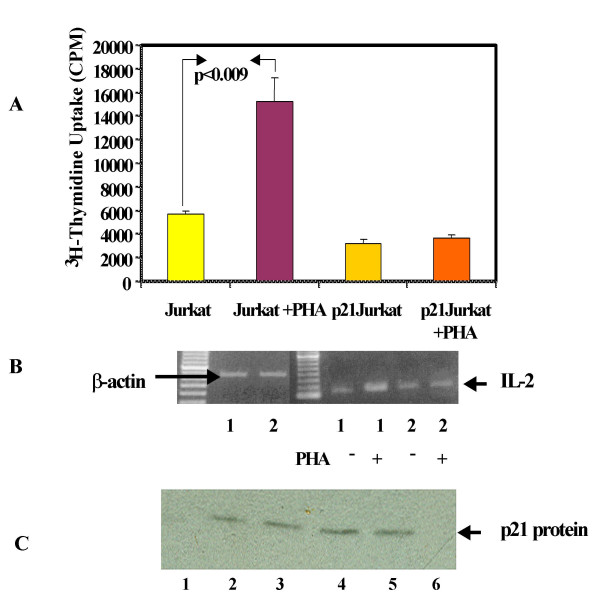
Over expression of p21WAF1/CIP1 inhibits proliferation and IL-2 mRNA expression in Jurkat T cells: A: A comparison of the proliferation of Jurkat T cells with and without p21 overexpression. B. Il-2 mRNA expression in PHA activated normal and p21 over-expressing Jurkat T cells. An identical expression of house keeping gene β-actin is also shown. C: p21 protein expression in four different clones of p21 overexpressing Jurkat T cells, Untreated (lane 1), p21 overexpressing (lane 2–5) and transfected with empty vector DNA (lane 6).